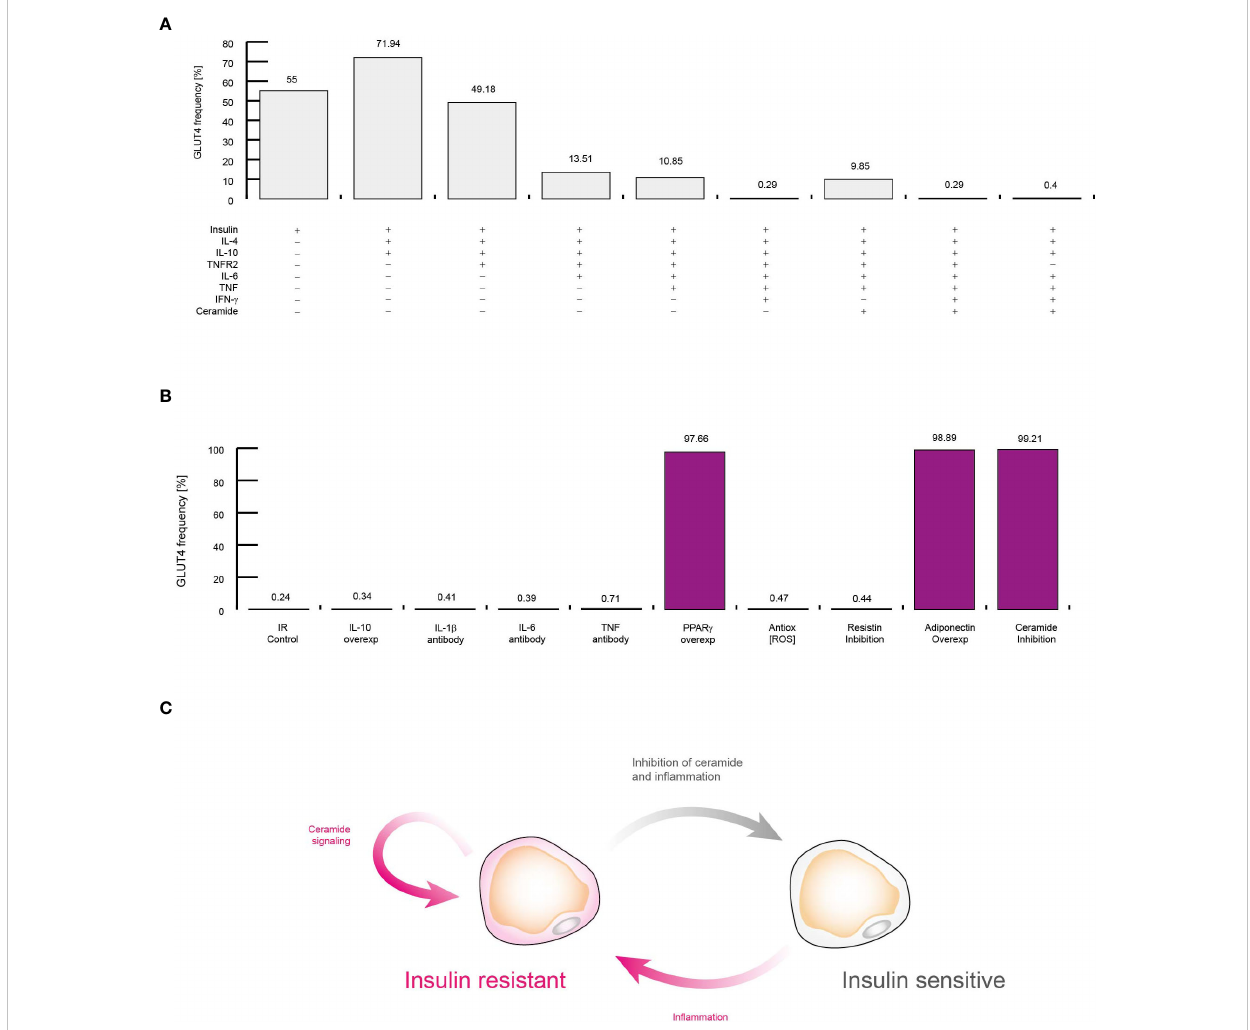
FIGURE 8 Molecular mechanism that sustains insulin resistance in adipocytes. (A) Simulations of controlling the insulin response in different conditions. Each simulation was performed by activating inputs of the adipocyte model (+) in presence of insulin (See methods). (B) Simulations of treatments against insulin resistance. Each simulation was performed considering high levels of TNF, IL-6, and IFN- g . The effect of neutralizing antibodies was simulated by turning off the corresponding node of each target molecule. Over-activation was simulated by turning on the target molecule for all time steps. (C) Conceptual model to explain insulin resistance. All data presented in this fi gure suggest that in fl ammation alone produce insulin resistance, and intracellular ceramide signaling sustains this pathological